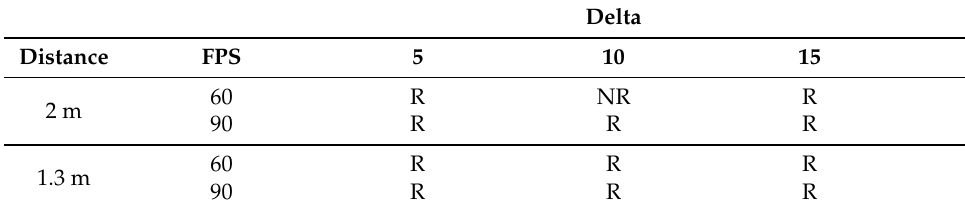
Table 5. Student’s t -test for diagonal movement.